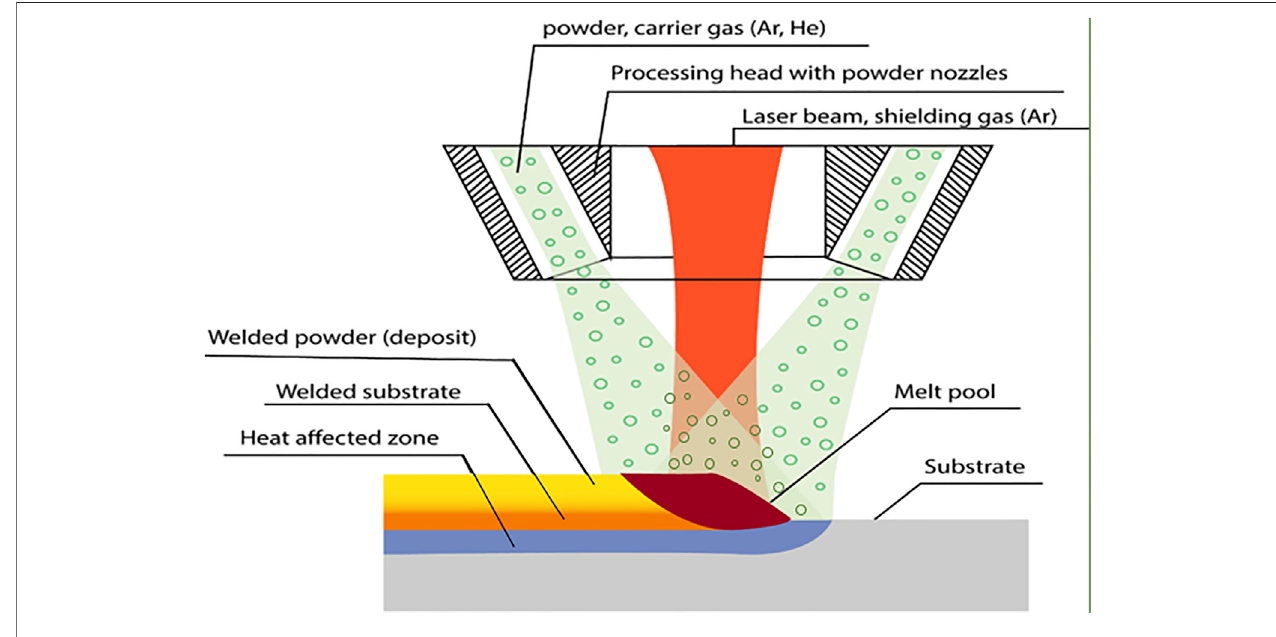
FIGURE 1 | Direct energy deposition coaxial nozzle.